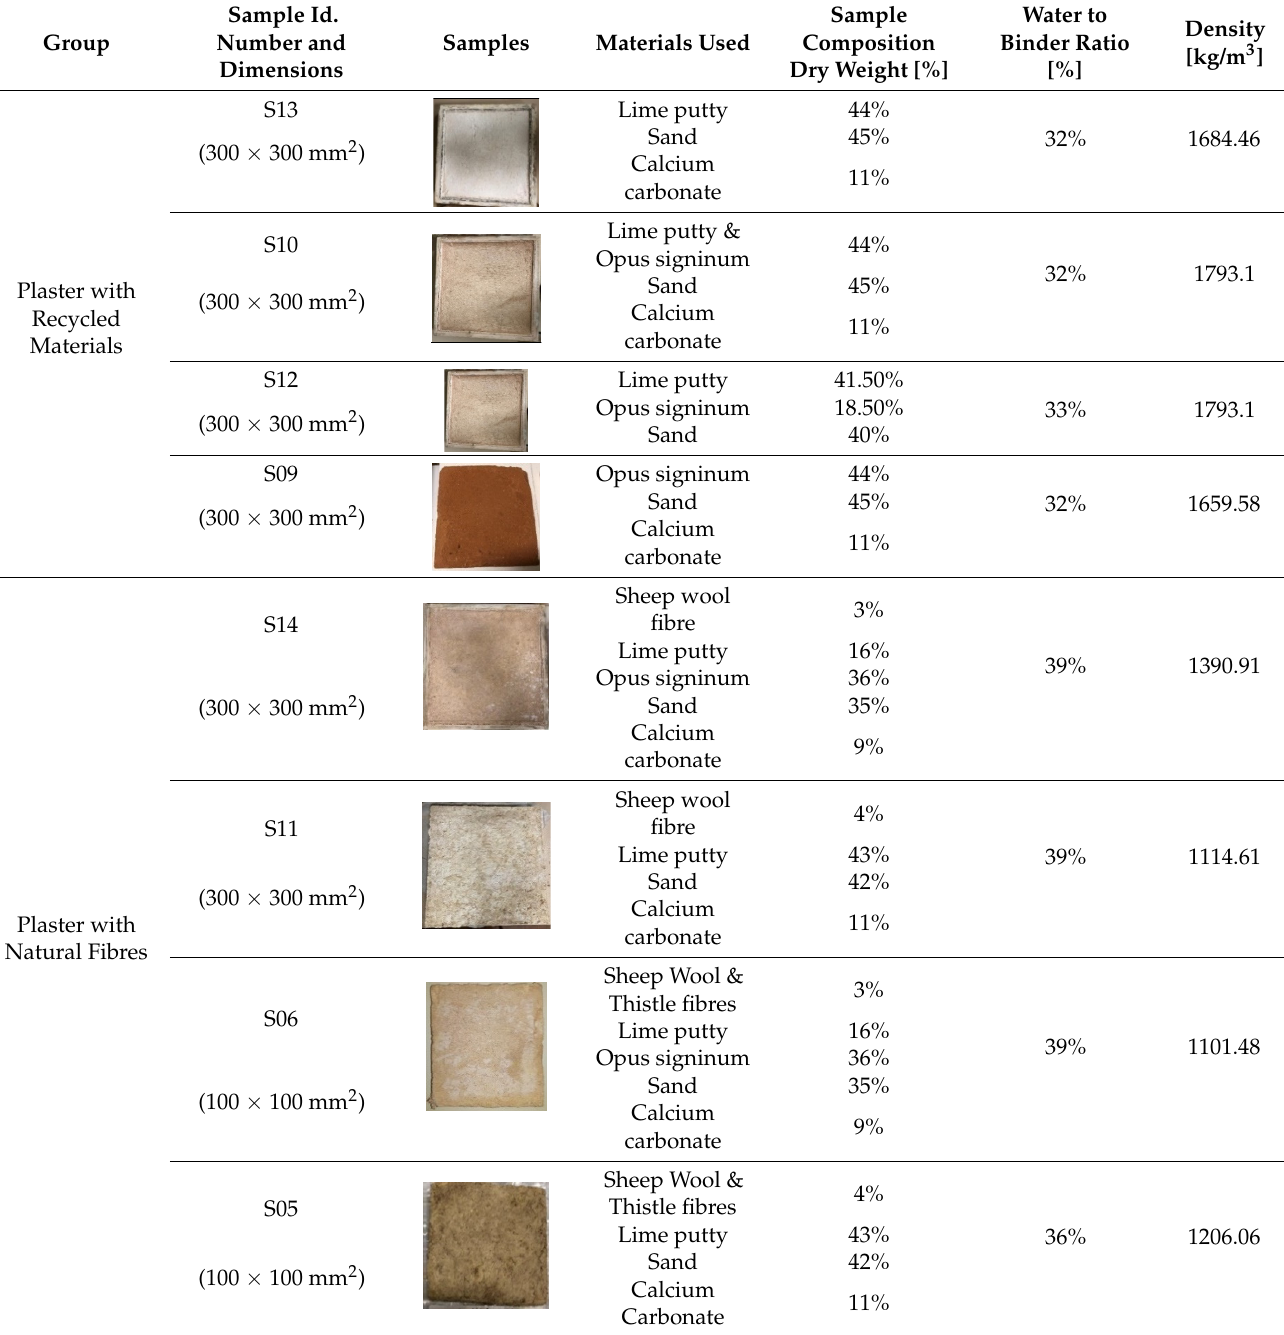
Table 2. Details of the analysed samples.